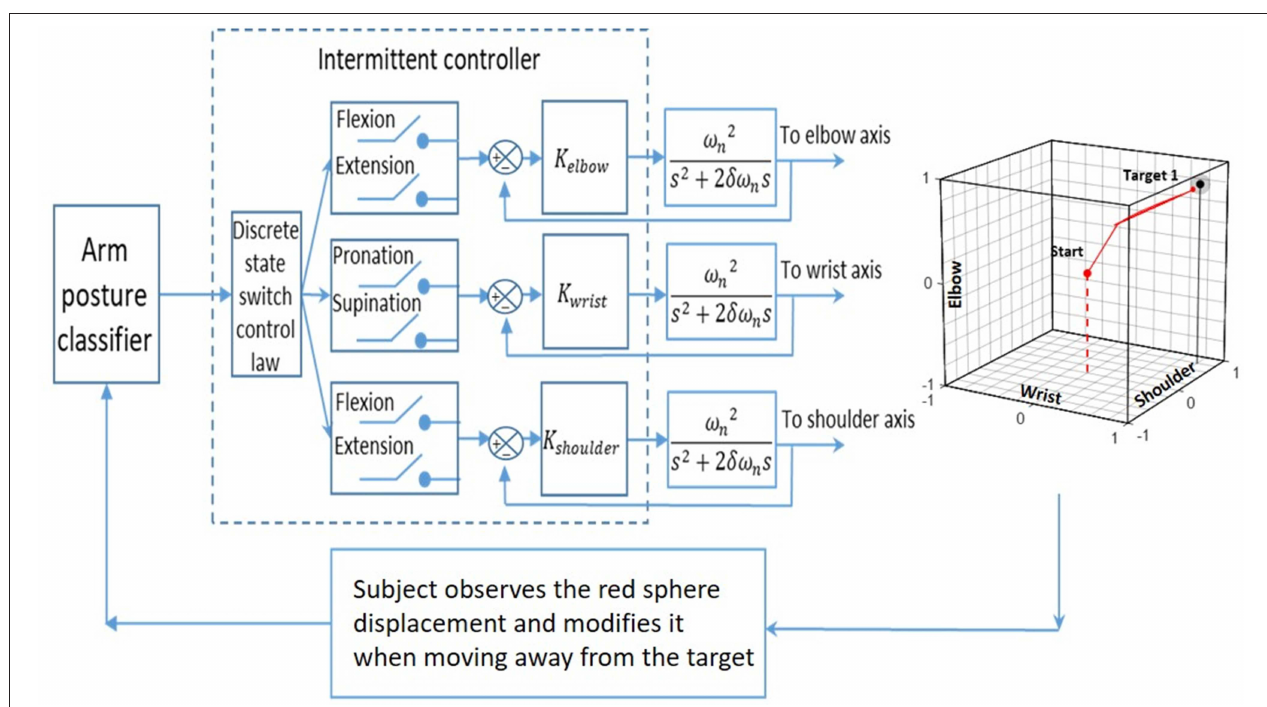
FIGURE 5 | The input of an arm posture classifier is fed to an intermittent controller that determines which switch to close in order to move the red sphere accordingly with the subject’s posture. The movement of the red sphere in each of the three joint axes is produced with a 2nd order system whose transfer function is given by Equation 1. The subject used the movement of the red sphere within the cube as visual feedback to produce sequential posture changes, and the objective was to reach a target in the cube.